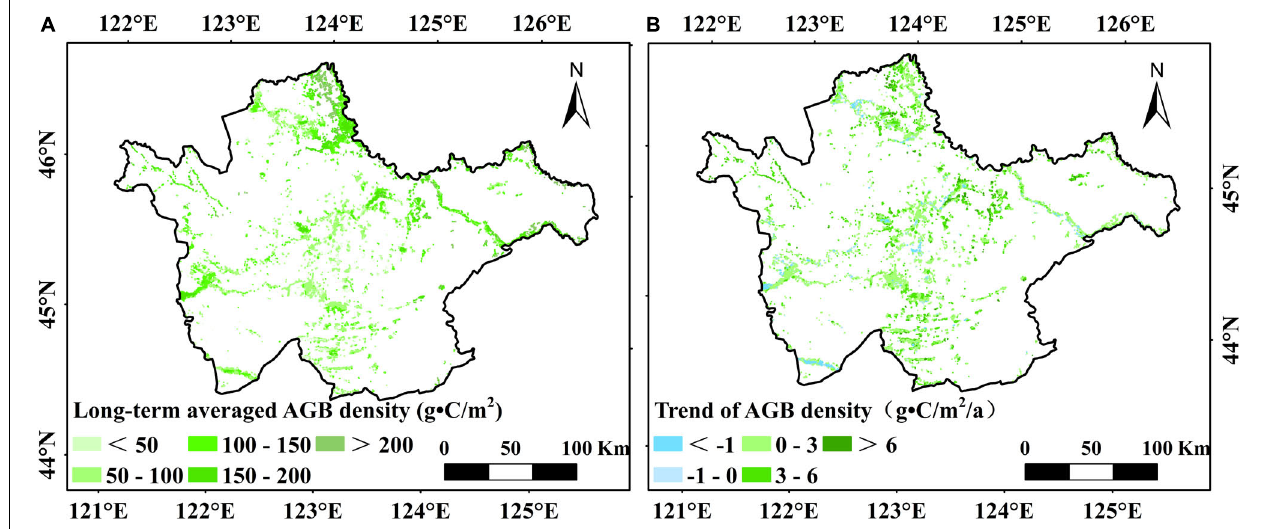
FIGURE 4 | Spatial patterns of the long-term averaged AGB density (A) and change trend of AGB density (B) in the western Songnen Plain marshes during 2000 –